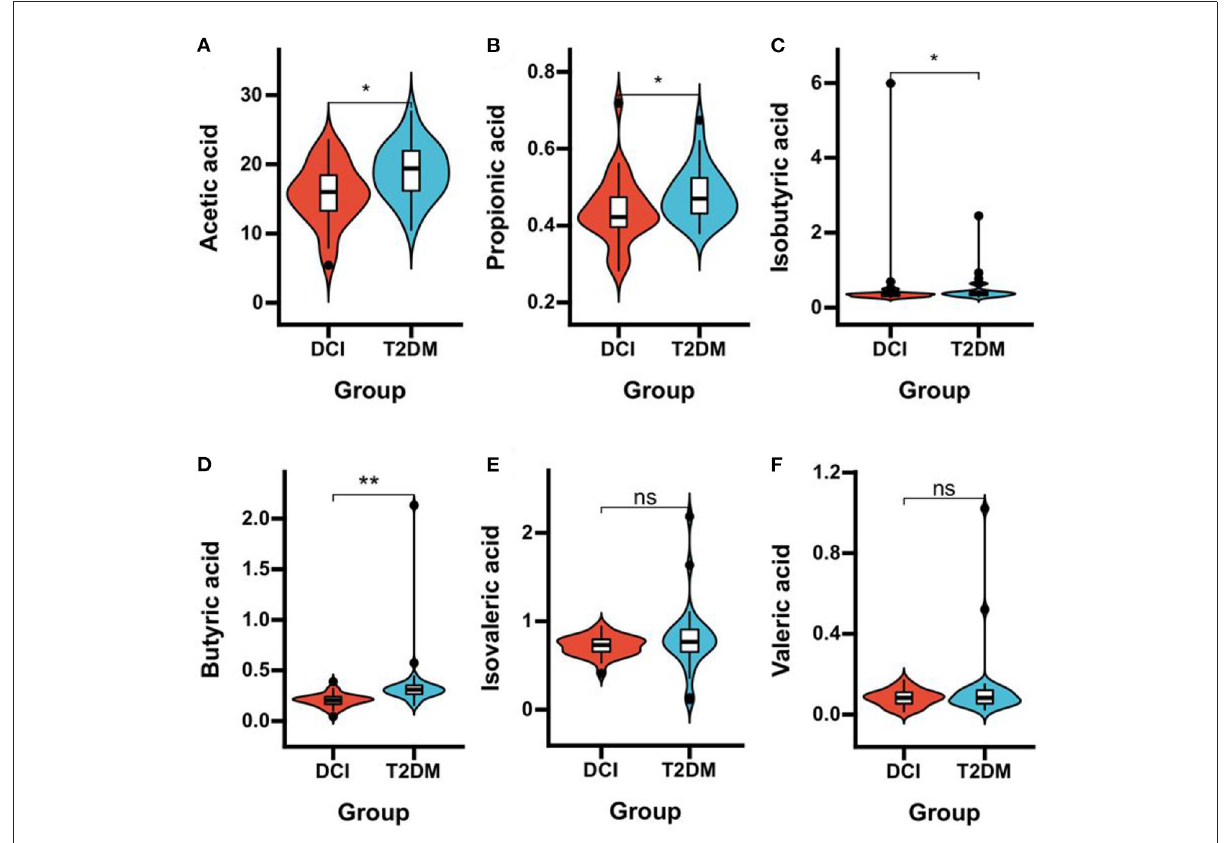
FIGURE3 Comparison of the plasma concentrations of SCFAs in DCI and T2DM groups. Violin plot showing data density and median with interquartile range for plasma concentrations of acetic acid (A) , propionic acid (B) , isobutyric acid (C) , butyric acid (D) , isovaleric acid (E) , and valeric acid (F) in DCI and T2DM groups. * P < 0.05, ** P <